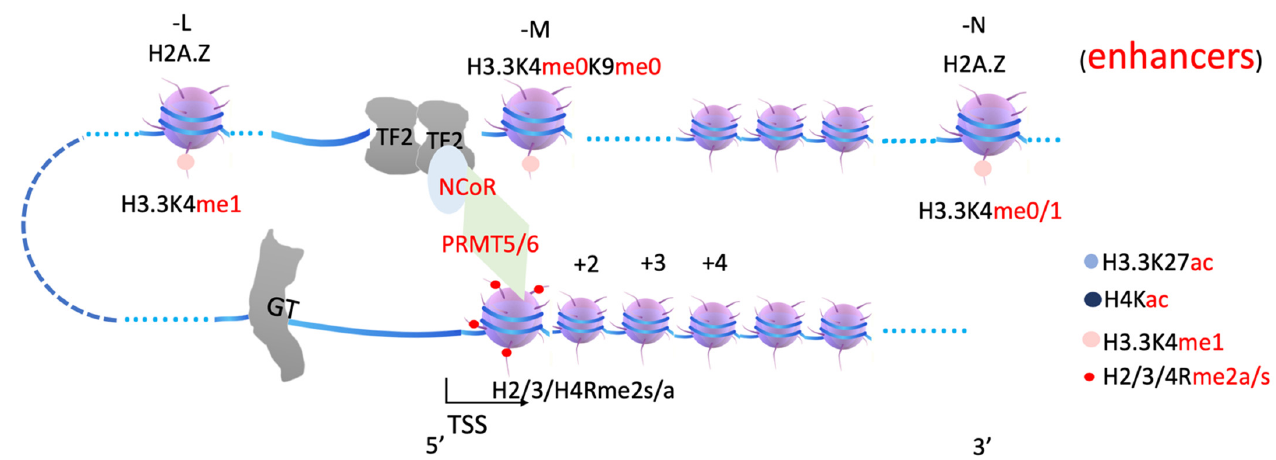
Figure 6. A model of transcription repression and arginine methylation on +1 nucleosome. When tran-